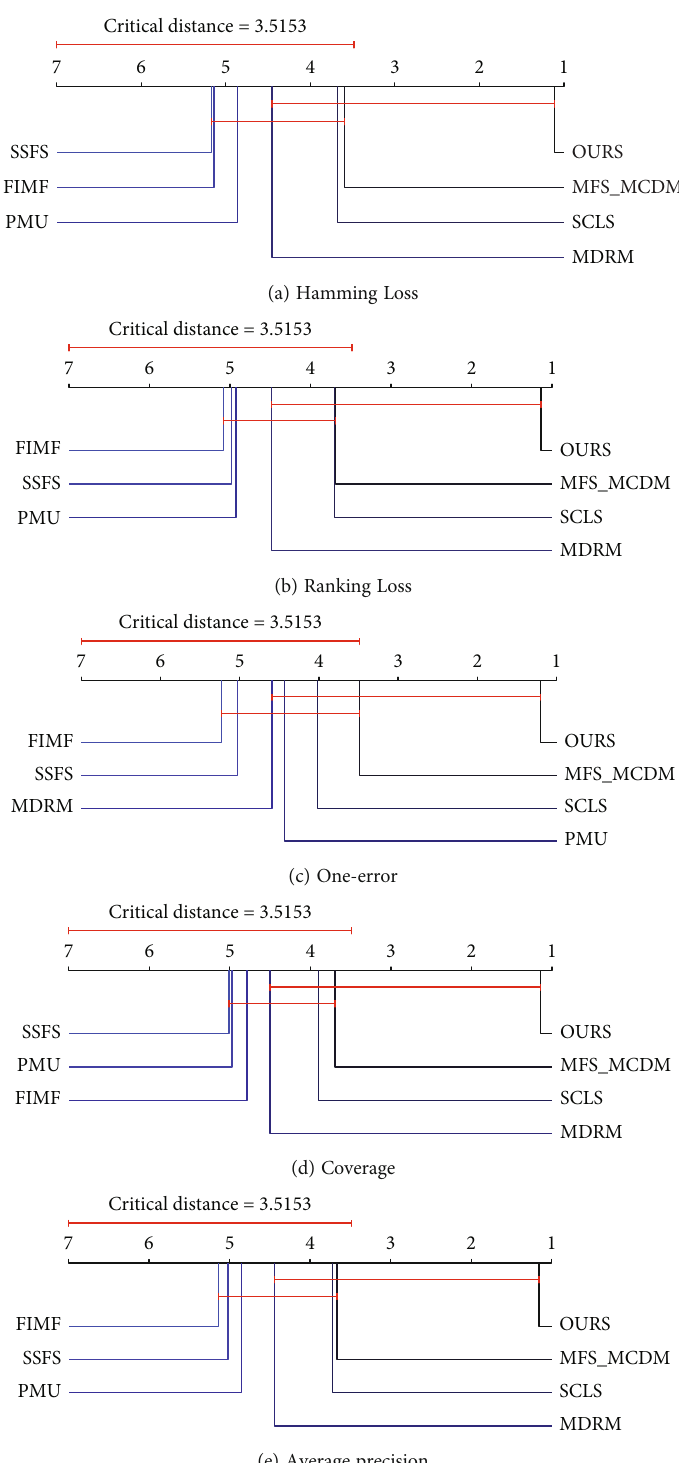
Figure 7: The form of the mean rank graph of the results of Bonferroni-Dunn